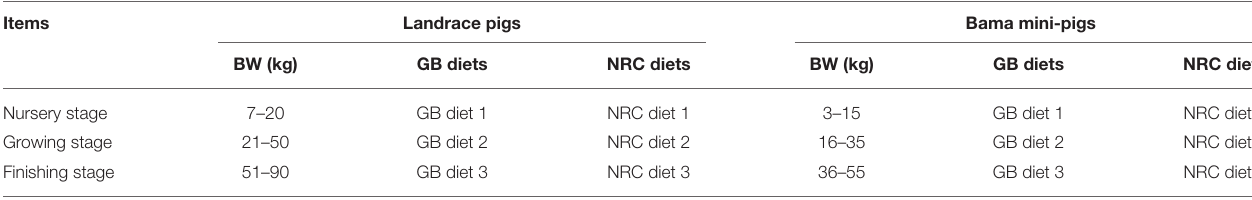
TABLE 1 | Experimental design and treatments.